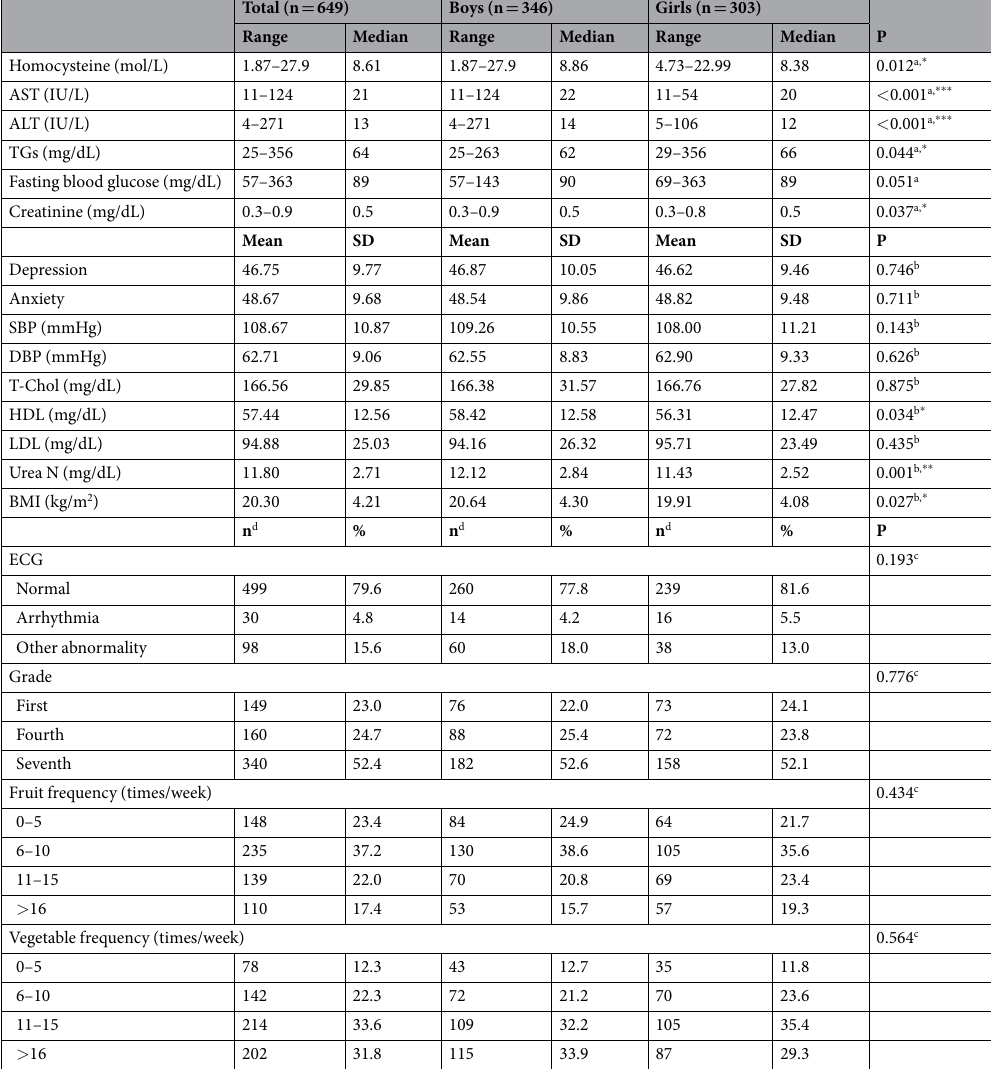
Table 1. Sex-wise distributions of characteristics and serum biochemical values. * P < 0.05; ** P < 0.01; *** P < 0.001. a Results from a Mann–Whitney U test. b Results from a t test. c Results from a chi-square test. d Total counts may vary because of missing data. AST, aspartate transaminase; ALT, alanine aminotransferase; TGs, triglycerides; SBP, systolic blood pressure; DBP, diastolic blood pressure; T-Chol, total cholesterol; HDL, high-density lipoprotein; LDL, low-density lipoprotein; ECG,